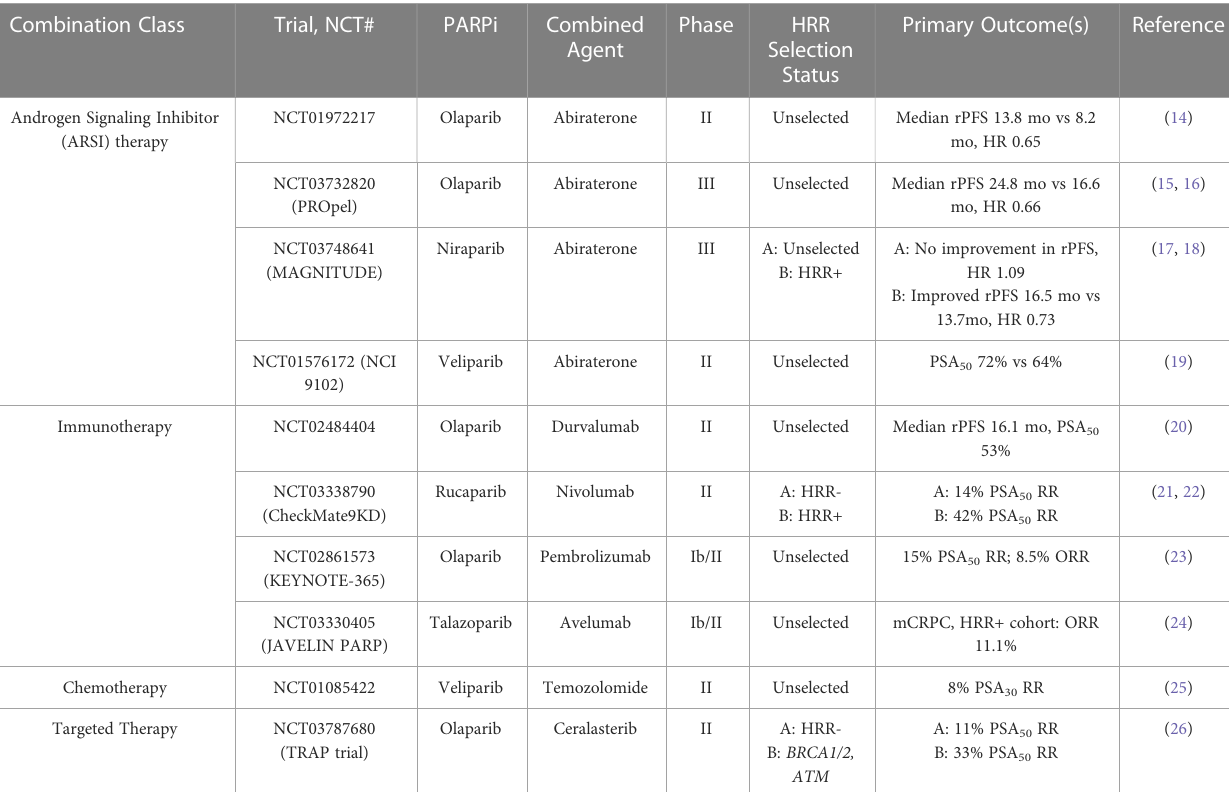
TABLE 2 Selected completed trials of PARPi combination therapies in